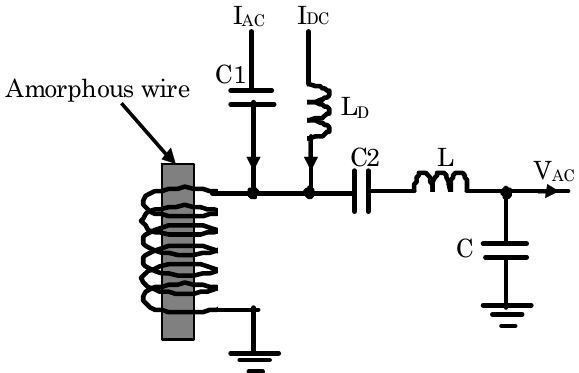
Figure 4. Schematic diagram of the amorphous wire magnetic sensor with the inductor-capacitor (LC) resonant circuit. The resonant frequency was the same as the frequency of the AC bias current.